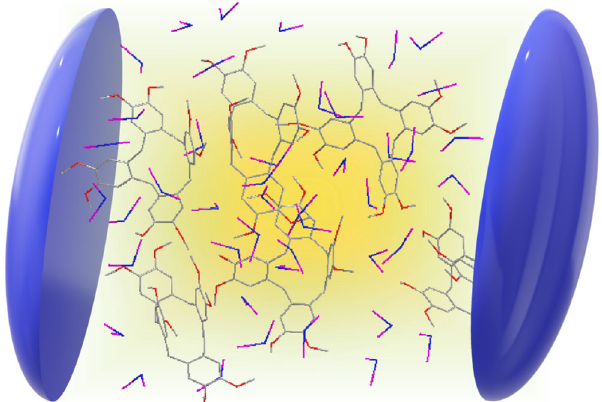
Fig. 1 Depiction of a microcavity. A large number of molecules can undergo a chemical reaction (e.g., electron-transfer-induced